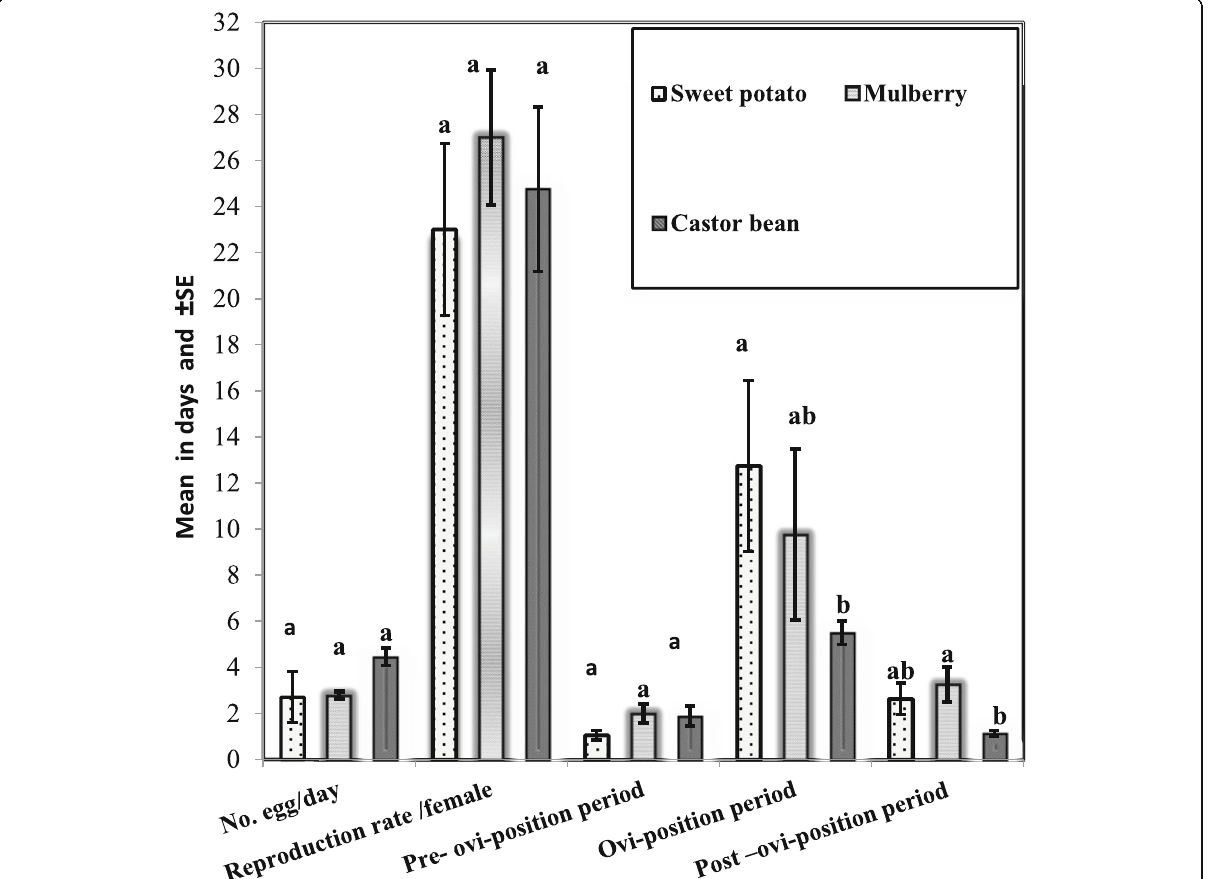
Fig. 1 Effect of different host plants on the biology and reproduction rate of Tetranychus urtica e